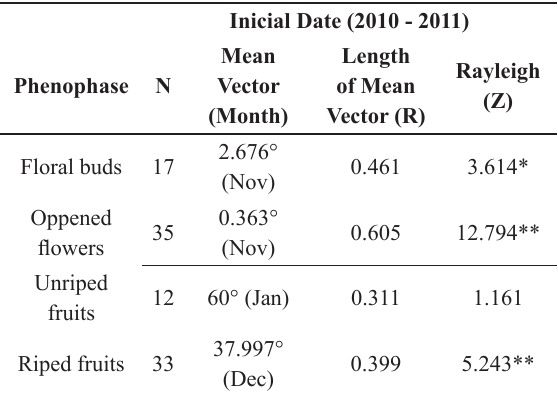
Circular statistical analysis of the seasonality occurrence in reproductive phenophases behavior during the study year. The Rayleigh test verified the significance of the vector mean or mean date (* refers to significant p values < 0.05, ** refers to significant p values < 0.01).